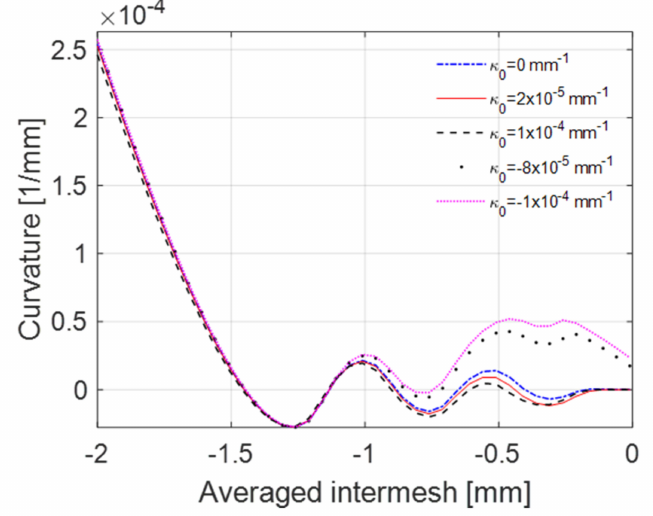
Figure 15. Residual curvature as a function of the averaged intermesh for the strip with an initial